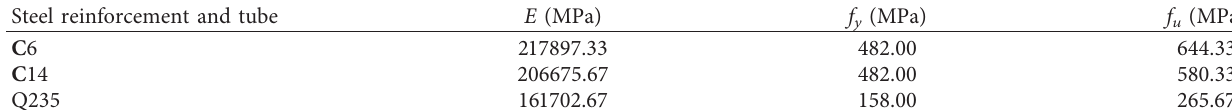
Table 1: Mechanical properties of steel from material quality testing.